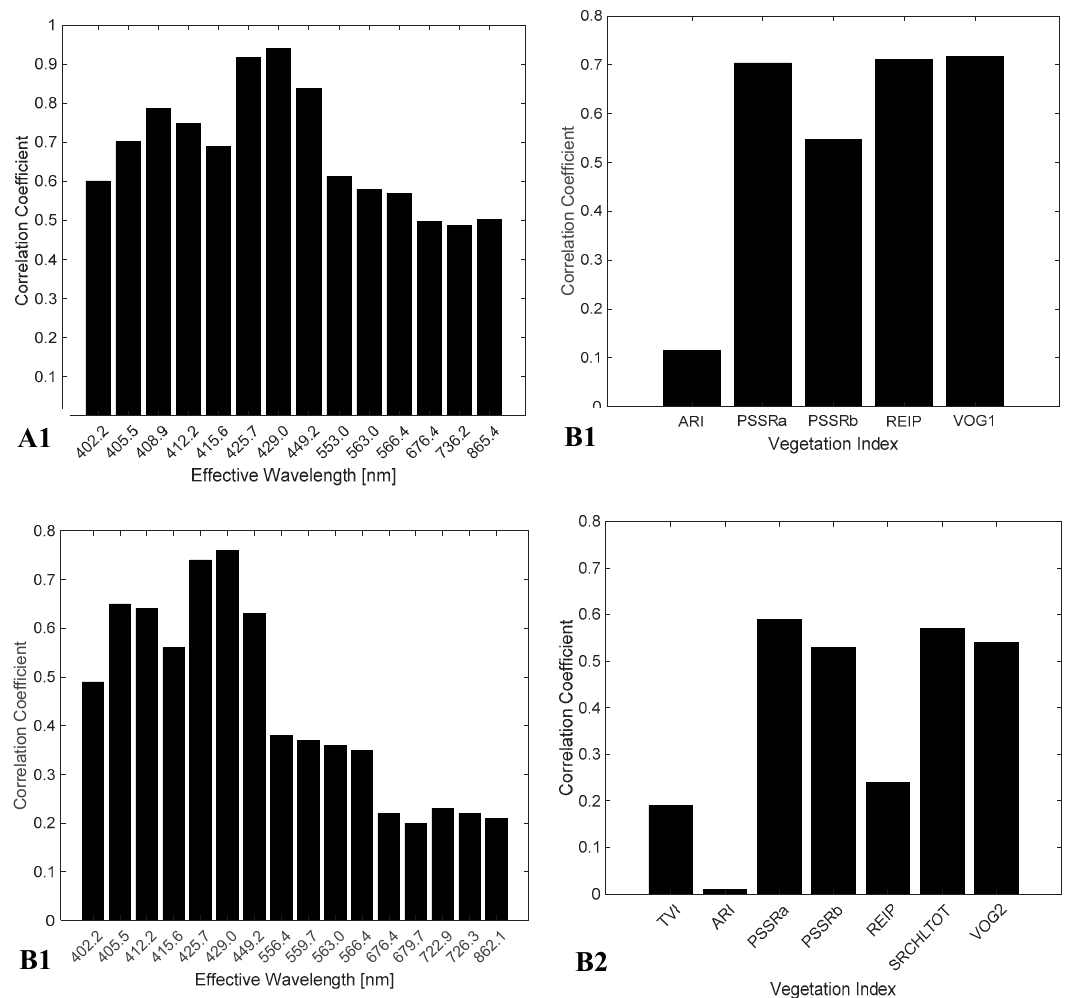
Figure 5. Pearson’s correlation coefficient between the topological structure of the input SOM layer and the class layer for each one of the features that were selected in form of EWs ( A1 and A2 ) and VIs ( B1 and B2 ). The index 1 denotes the results before the outlier elimination, while the index 2 denotes the respective results after the outlier elimination.